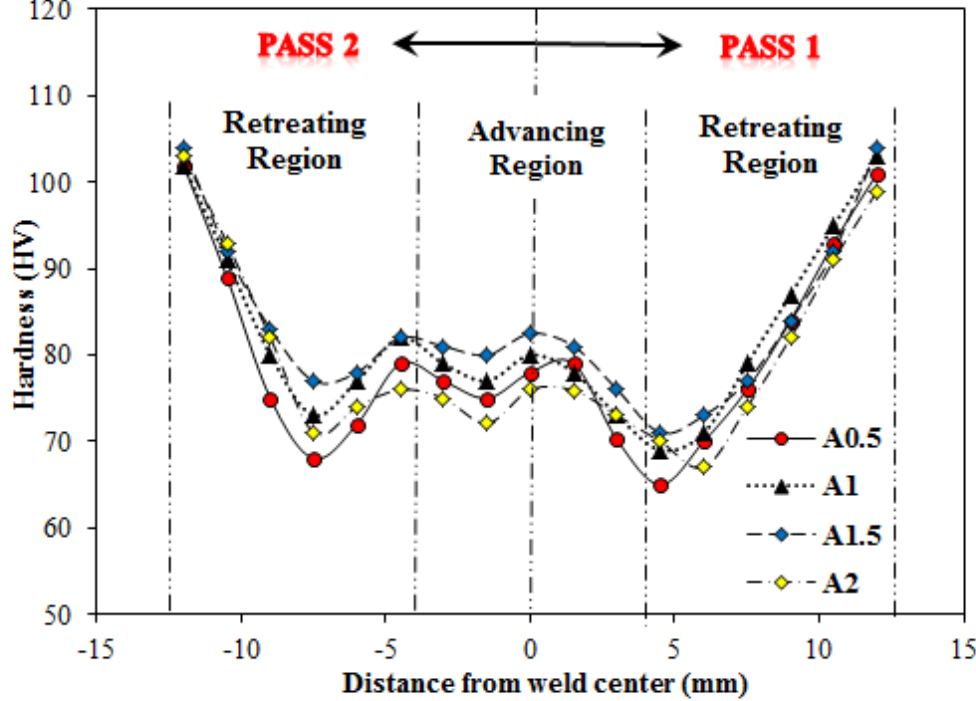
Figure 11. Hardness profiles of AP-FSW specimens with different tool offsets.